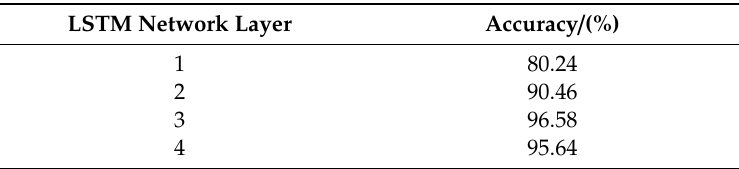
Table 3. LSTM network layer comparison results.